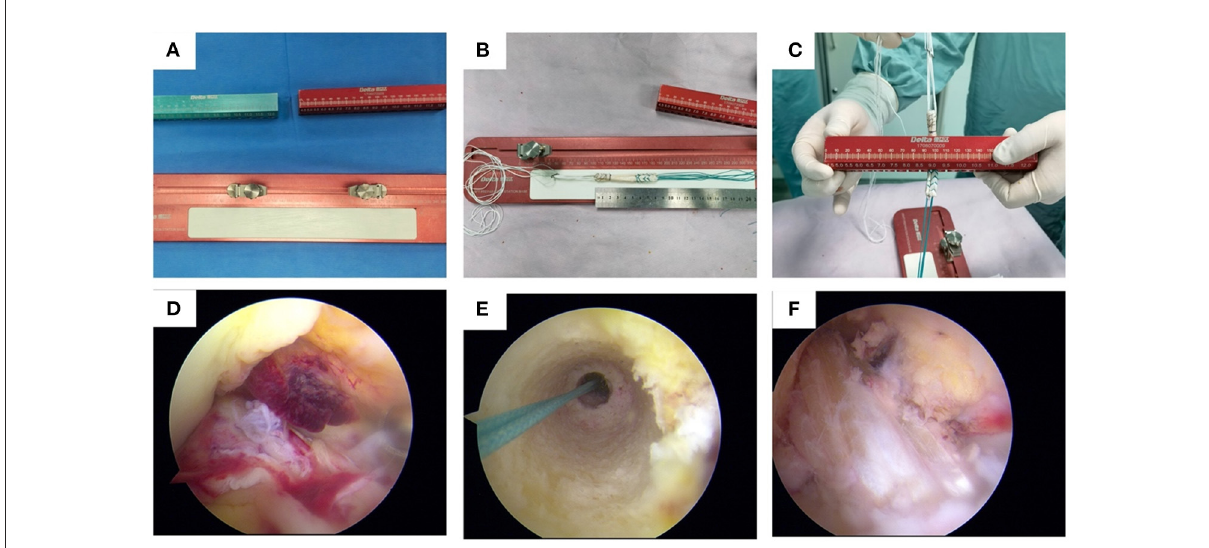
FIGURE1 Surgical procedures of ACL reconstruction. (A) the tendon preparation panel of Delta Medical; (B) measuring the length of the autogenous tendon; (C) measuring the diameter of the autogenous tendon; (D) confirming the diagnosis of ACL injury; (E) preparing the femoral tunnel; (F) final repair configuration of the ACL reconstruction.